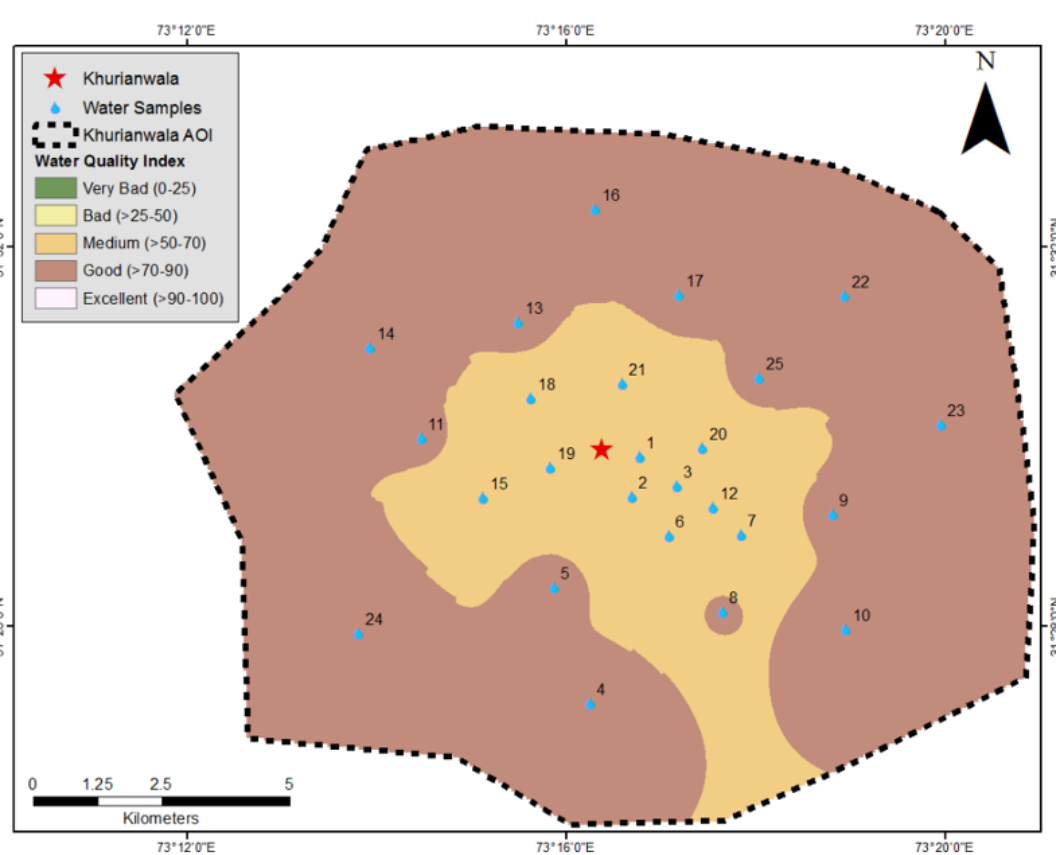
Figure 4. Mapping according to the distribution of water quality index (WQI) values based on drinking water quality